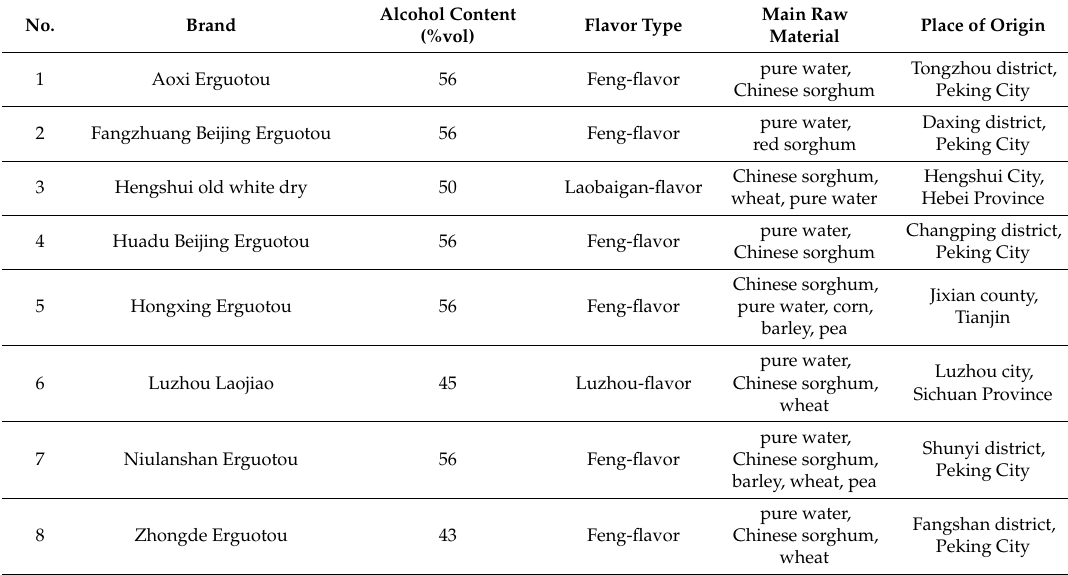
Table 1. Liquor sample